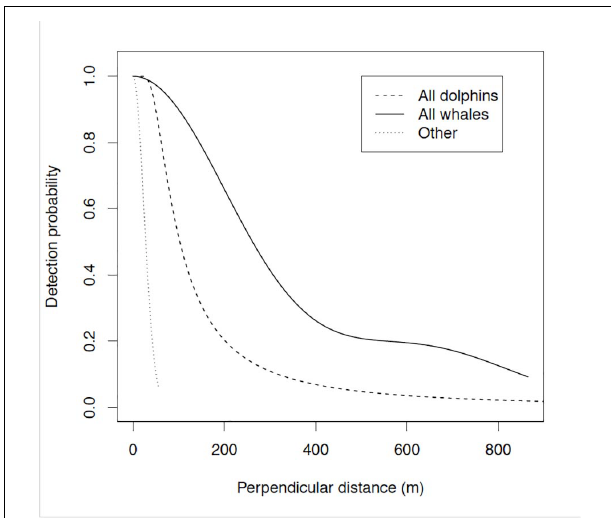
FIGURE 7 | The selected half normal detection function for all surveyed species, pooled as a function of perpendicular distance. Illustrative detection probability of dolphins is represented by a dashed line, whales by a solid line, and of other megafauna by a dotted line. The curves show detection decreasing with increasing perpendicular distance. Detection probability is assumed to be certain [i.e., y ( =1)] on the track line [i.e., x ( =0)]. Confidence intervals for whales are